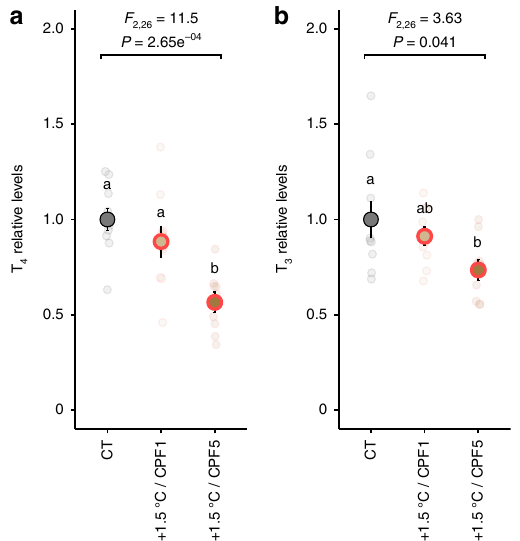
Fig. 4 Effects of increased temperature and chlorpyrifos co-exposure on TH levels. a , b Respective T 4 levels ( n = 29) and T 3 levels ( n = 29) in d2 A. triostegus exposed to increased temperature (CT = control, 28.5 °C; + 1.5 °C = 30.0 °C) and CPF (CT = control, no CPF; CPF1 and CPF5 = CPF at 1 and 5 µ g L − 1 , respectively). Data are indicated as mean (opaque circles) ± SE (error bars), and transparent circles indicate each data point. Letters indicate statistically different groups according to two-sided Tukey post hoc tests following LM ( F ). Source data are provided as a Source Data fi